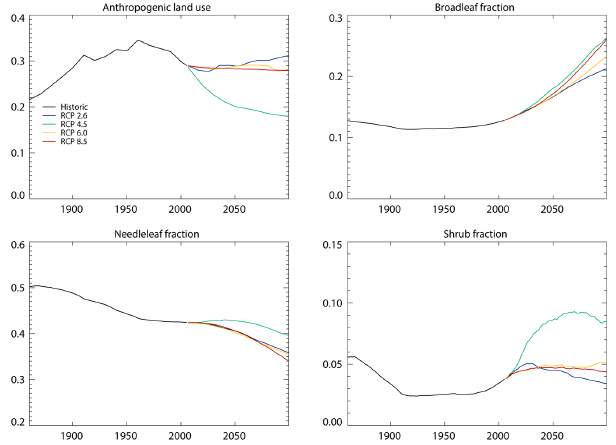
Figure 10. Fractional cover of (a) anthropogenic land use (disturbed fraction), (b) broadleaf tree, (c) needleleaf tree and (d) shrub in HadGEM2-ES in northern South America under the 4 RCPs. Note difference scales used on y